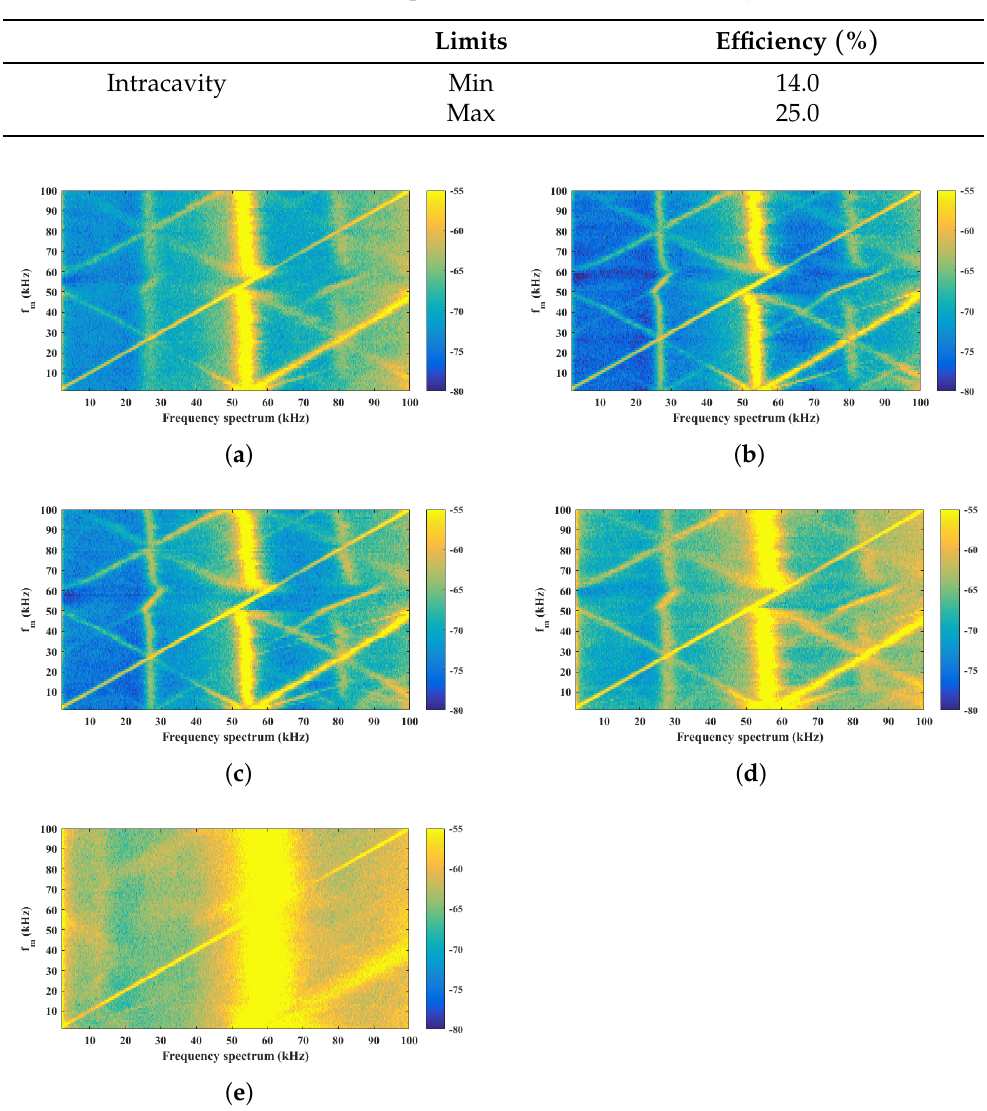
Table 2. Optical efficiency conversion with intra-cavity configuration maintaining the pump of